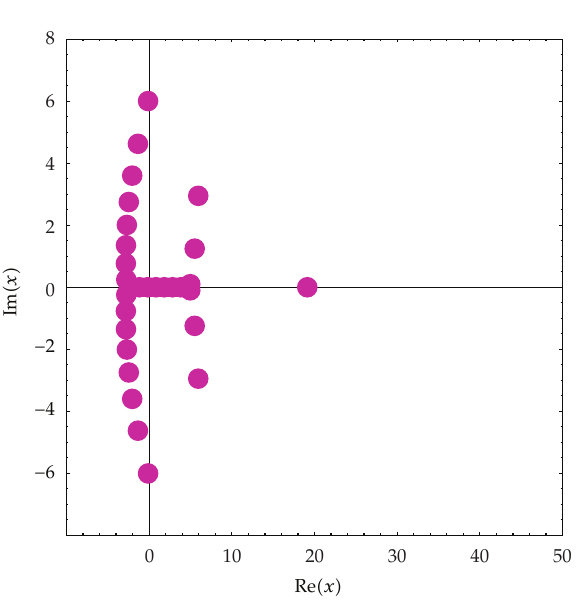
Figure 13: Zero of G 30 , 1 / 5 (cid:2) x (cid:3)